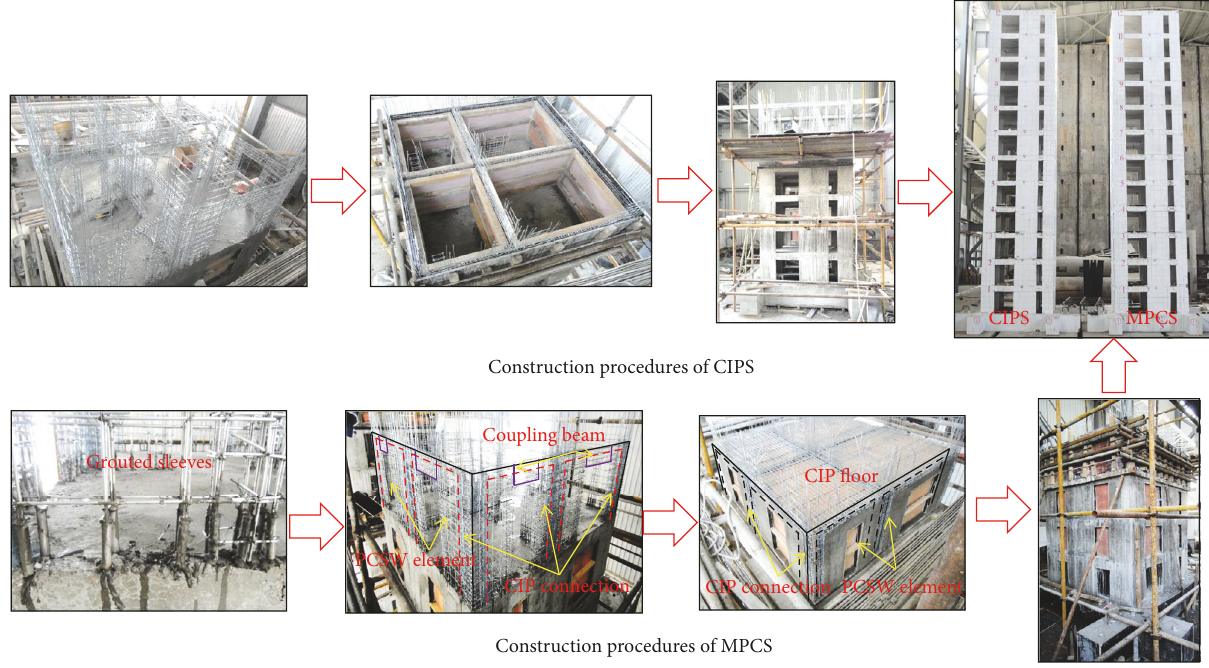
Figure 3: Construction procedures of CIPS and MPCS.